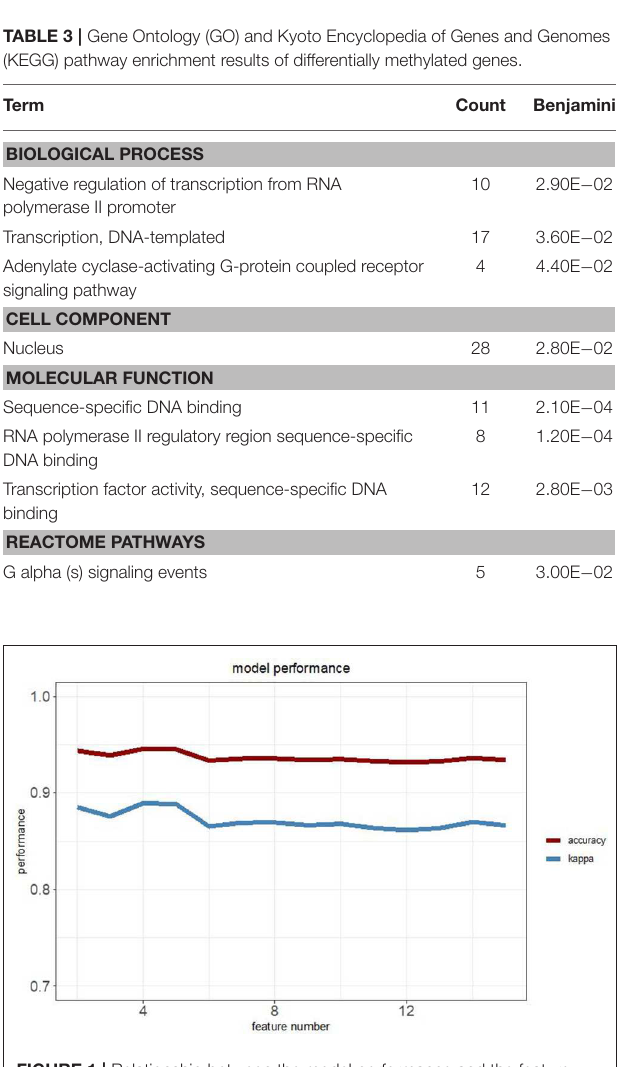
FIGURE 1 | Relationship between the model performance and the feature numbers based on both accuracy and kappa